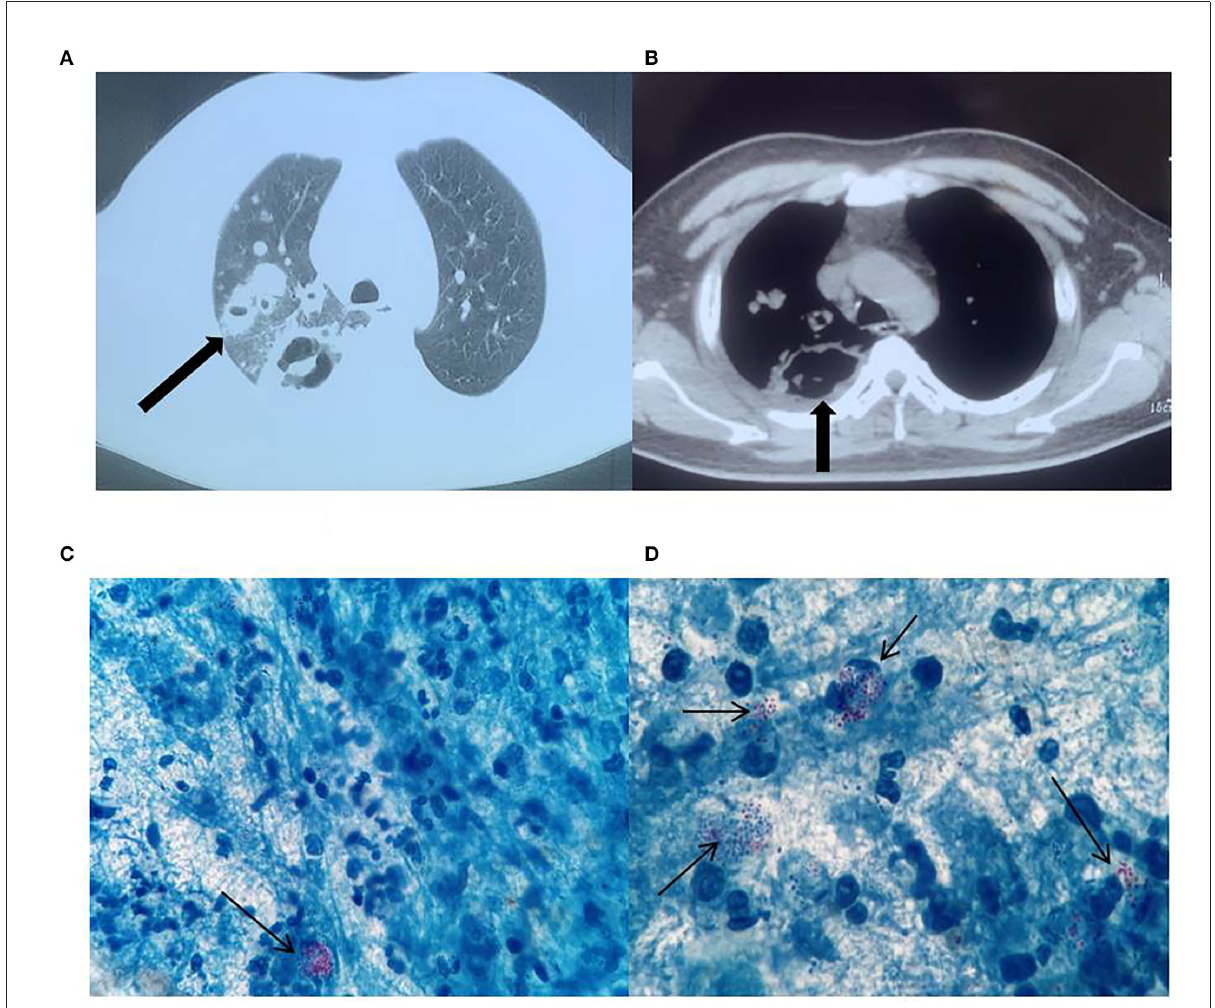
FIGURE1 Chest computed tomography (CT) images. Right lung cavity (A) , thickening of and adherence to the right pleura (B) . Acid-fast bacteria in the microscopic field of view (C,D) , × 1000.